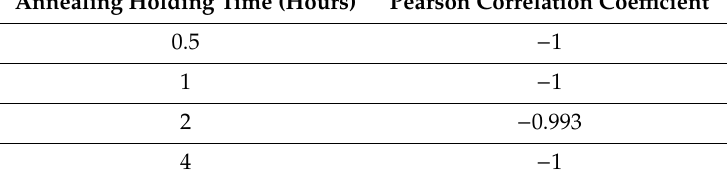
Table 4. Correlation between annealing temperature and delta ferrite composition at di ff erent holding times.